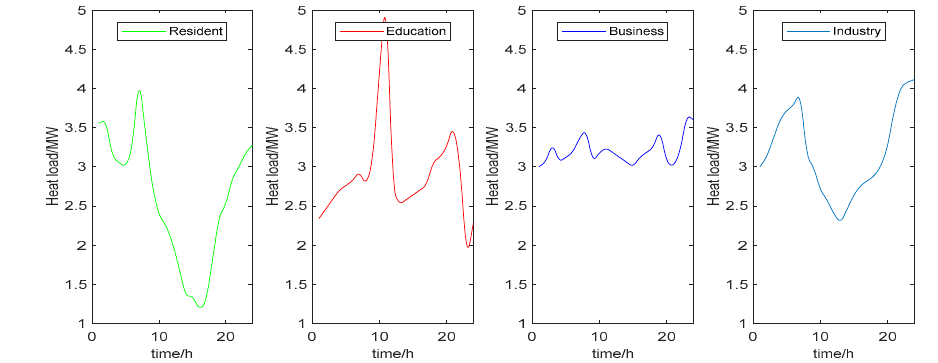
Figure 4. Fuzzy c-means clustering results of four types of users. 409